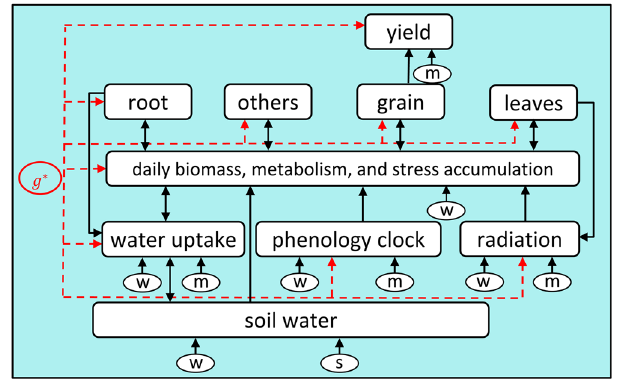
Fig. 7 Illustration of a simpli fi ed maize growth model. Here “ w ” , “ s ” , “ m ” represent weather, soil, and management variables, respectively, and “ g ” represents the set of parameters that are determined solely by the genotype and independent of the environment. The arrows indicate how environmental variables and genetic parameters in fl uence different modules and eventually determine